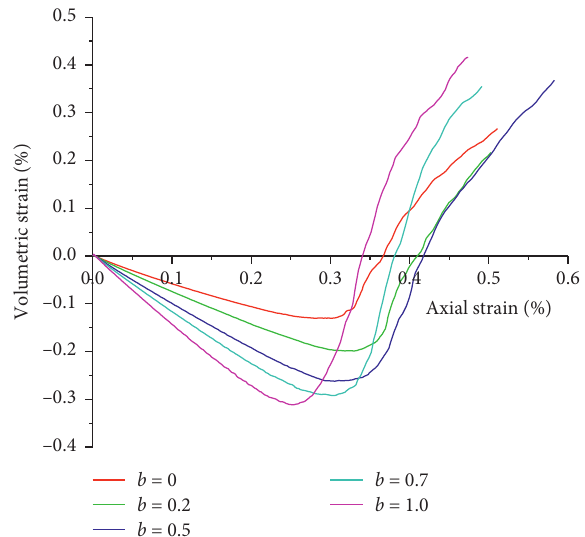
Figure 7: Relationships between volumetric strain and axial strain with different b